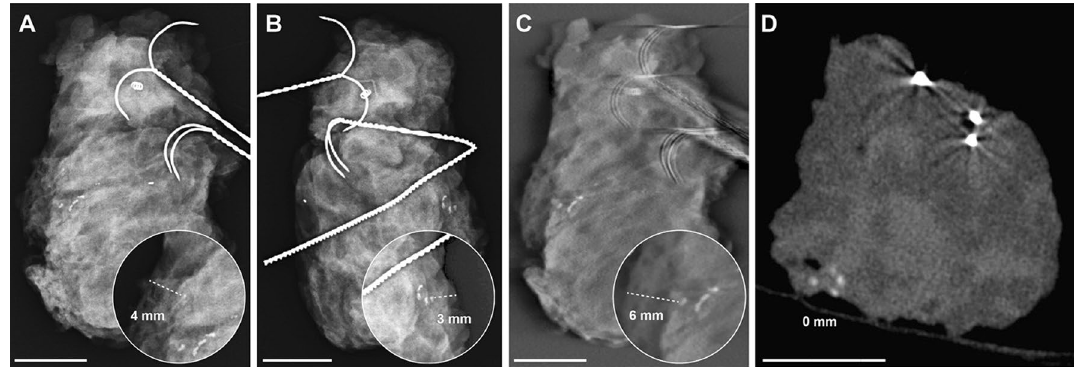
Figure 2. Breast specimen with microcalcifications, histopathologically proven as invasive carcinoma of no special type, clip and wires in ( A ) and ( B ) the two standard projections of specimen mammography (DM), ( C ) in digital breast tomosynthesis (DBT) and ( D ) cone-beam computed tomography (CBCT) imaging. Whilst the microcalcifications project 4 or 3 mm from the margin in DM (dependent of projection), there are 6 mm distance from the margin in DBT as the smaller calcification was not reliably detected in the blinded measurements and in the CBCT the microcalcifications could be clearly localized directly at the margin due to real 3D placement and reconstructions. Some clear metal wear [middle of ( A ) and close to middle right margin in ( B )] should not be mistaken for microcalcification. In addition, metal-related artifacts around the wires are seen in ( C ) DBT and ( D ) CBCT images. The white scalebar indicates 1